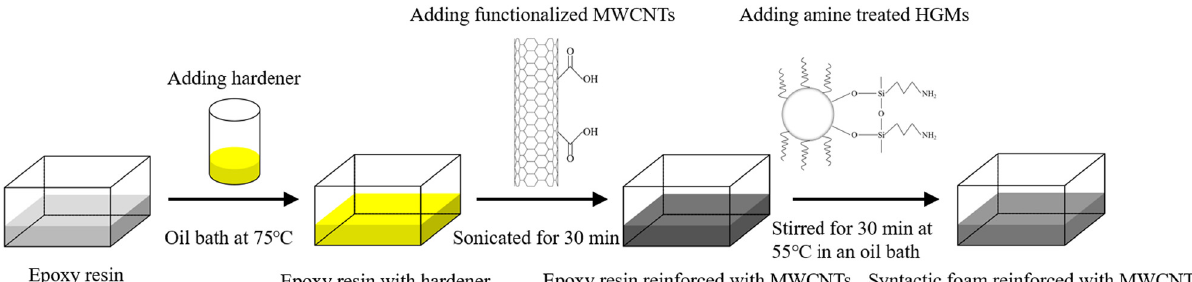
Figure 1: Synthetic and preparation